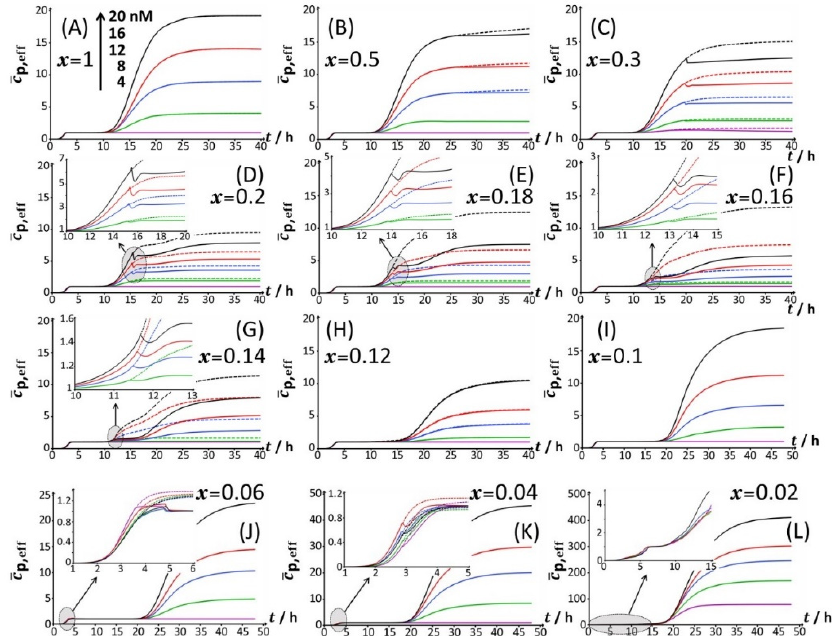
Figure 10. Dependence of the cell photoactivity c p,eff (Equation (10)) on time t and total bulk Cd concentration (specified) in 0.1% tryptone for different glucose-to-xylose concentration ratios corresponding to 0.02 ≤ x ≤ 1 (indicated). The scale in Cd concentration and the associated color nomenclature specified in ( A ) apply to panels ( B – L ). Solid lines: cell photoactivity retrieved from the theoretical reconstruction of the measured time-dependent bioluminescence profiles displayed in Figure 2 following the methodology delineated in Section 3 (Equations (9) and (10)). Dotted lines correspond to predictions in the absence of truncation in peak P2 (panels ( B – G )) and in peak P1 (panels ( J , K )). The theoretical time-dependent bioluminescence patterns corresponding to the c p,eff data given in this Figure 10 are shown in Figure 2 (solid lines therein) and in Figures 3 and 4 where zooms of the P2 and P1 emission modes, respectively, are